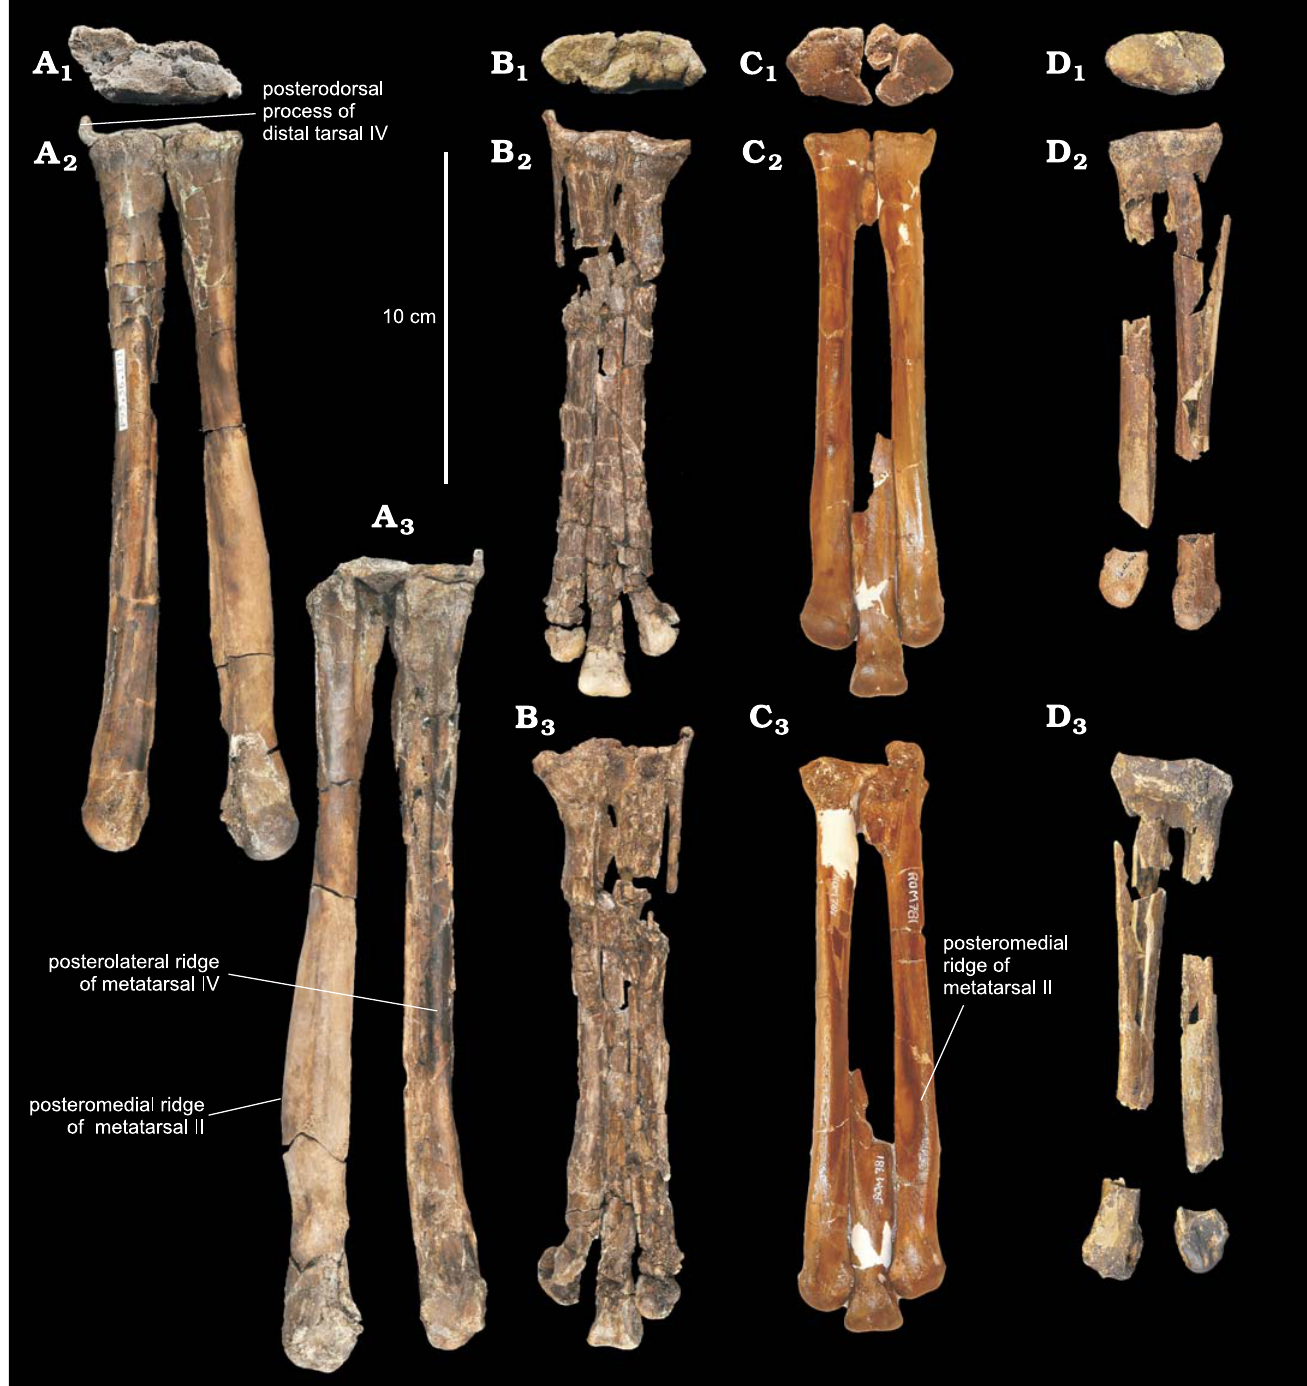
Fig. 3. Elmisaurine dinosaur Leptorhynchos elegans (Parks, 1933) from the Upper Campanian Dinosaur Park Formation, Dinosaur Provincial Park, Alberta, Canada. A . TMP 1993.036.0181. B . TMP 1982.016.0006. C . ROM 781. D . TMP 1996.012.0141. Tarsometatarsi in proximal (A 1 –D 1 ), anterior (A 2 –D 2 ), and posterior (A 3 –D 3 )